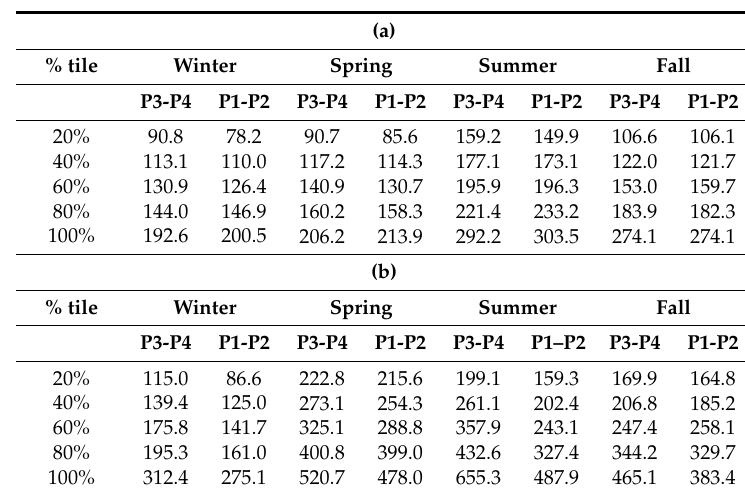
Table 4. The distribution of precipitation (mm) by quintile and season for the (a) Belgorod Region, and (b) central USA during P3 and P4 versus P1 and